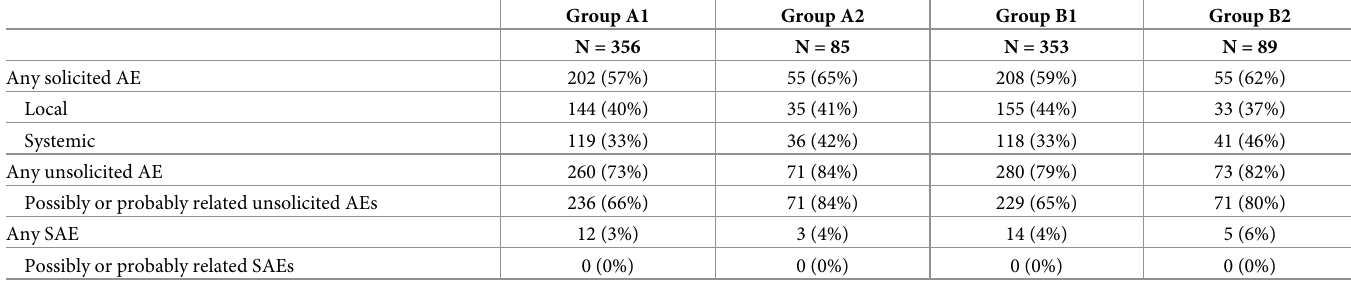
Table 3. Number and percentages of participants with solicited adverse events after any vaccination, and unsolicited and serious adverse events throughout the study (safety